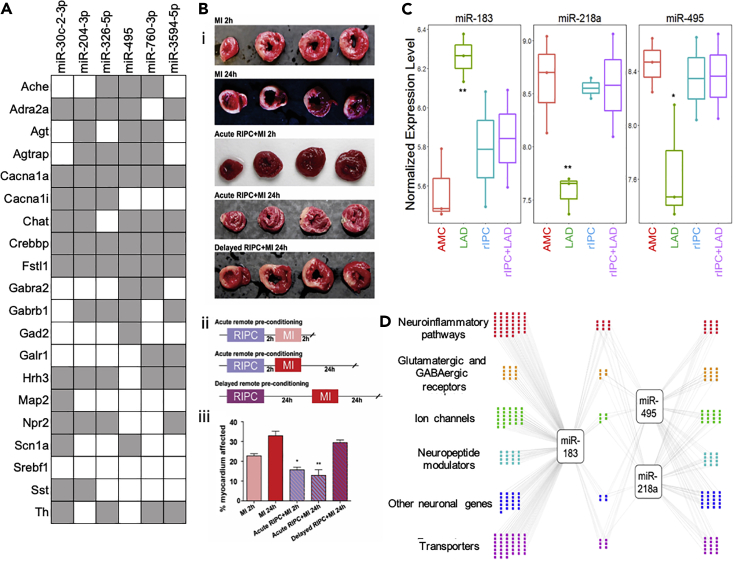
Likely microRNA mediators of DMV neuronal gene expression changes from RIPC(A) Putative regulatory interaction matrix microRNA regulators RIPC-downregulated target genes. Although the significant genes that were discussed in this work are present, several other genes with the same expression pattern that did not meet the cutoff for statistical significance were also included in the query. Putative binding was determined through the use of several algorithms (mirWalk, RNA22, miRanda, and Targetscan) and a “hit” taken when more than one of these was determined there to be a putative binding site in the 3′UTR.(B) Effects of remote ischemic preconditioning (RIPC) on the extent of myocardial tissue damage are present after 2 h and subside by 24 h. (i) Cardiac tissue after each treatment combination stained with triphenyl tetrazolium chloride (TTC) with areas of infarct shown in white and viable myocardium in red. (ii) Timeline of each RIPC experimental treatment group. The MI 2h and MI 24h groups did not have an RIPC component and only included induction of MI with the respective waiting time to tissue collection. (iii) Quantitative analysis of infarct size expressed as percentage of left ventricle (mean ± SEM). N = 3–5 per group. ∗p < 0.05, ∗∗p < 0.005.(C) Putative microRNA control points in the DMV that showed dysregulation by LAD and normalization by RIPC. ∗∗p < 0.005; ∗p < 0.05, compared with age-matched control. We tested for expression and differential regulation of ~400 microRNAs using Nanostring digital counting platform. A total of 146 microRNAs were detected (Figure S13A). Template analysis identified a subset of microRNAs that showed dysregulation in LAD and normalization by RIPC (Figure S13B). Of these, a set of three microRNAs showed >2-fold differential regulation due to LAD compared with RIPC.(D) Differentially expressed microRNAs target genes in processes relevant to neuronal plasticity and neuroinflammatory processes. We used miRWalk to predict genes relevant to neuronal processes that are putative targets of the three high-priority differentially regulated microRNAs. We filtered miRWalk predictions for those expressed in the DMV using available RNA-seq data from rat models of autonomic dysfunction. Colored dots represent the target genes categorized based on gene ontology and functional annotation.